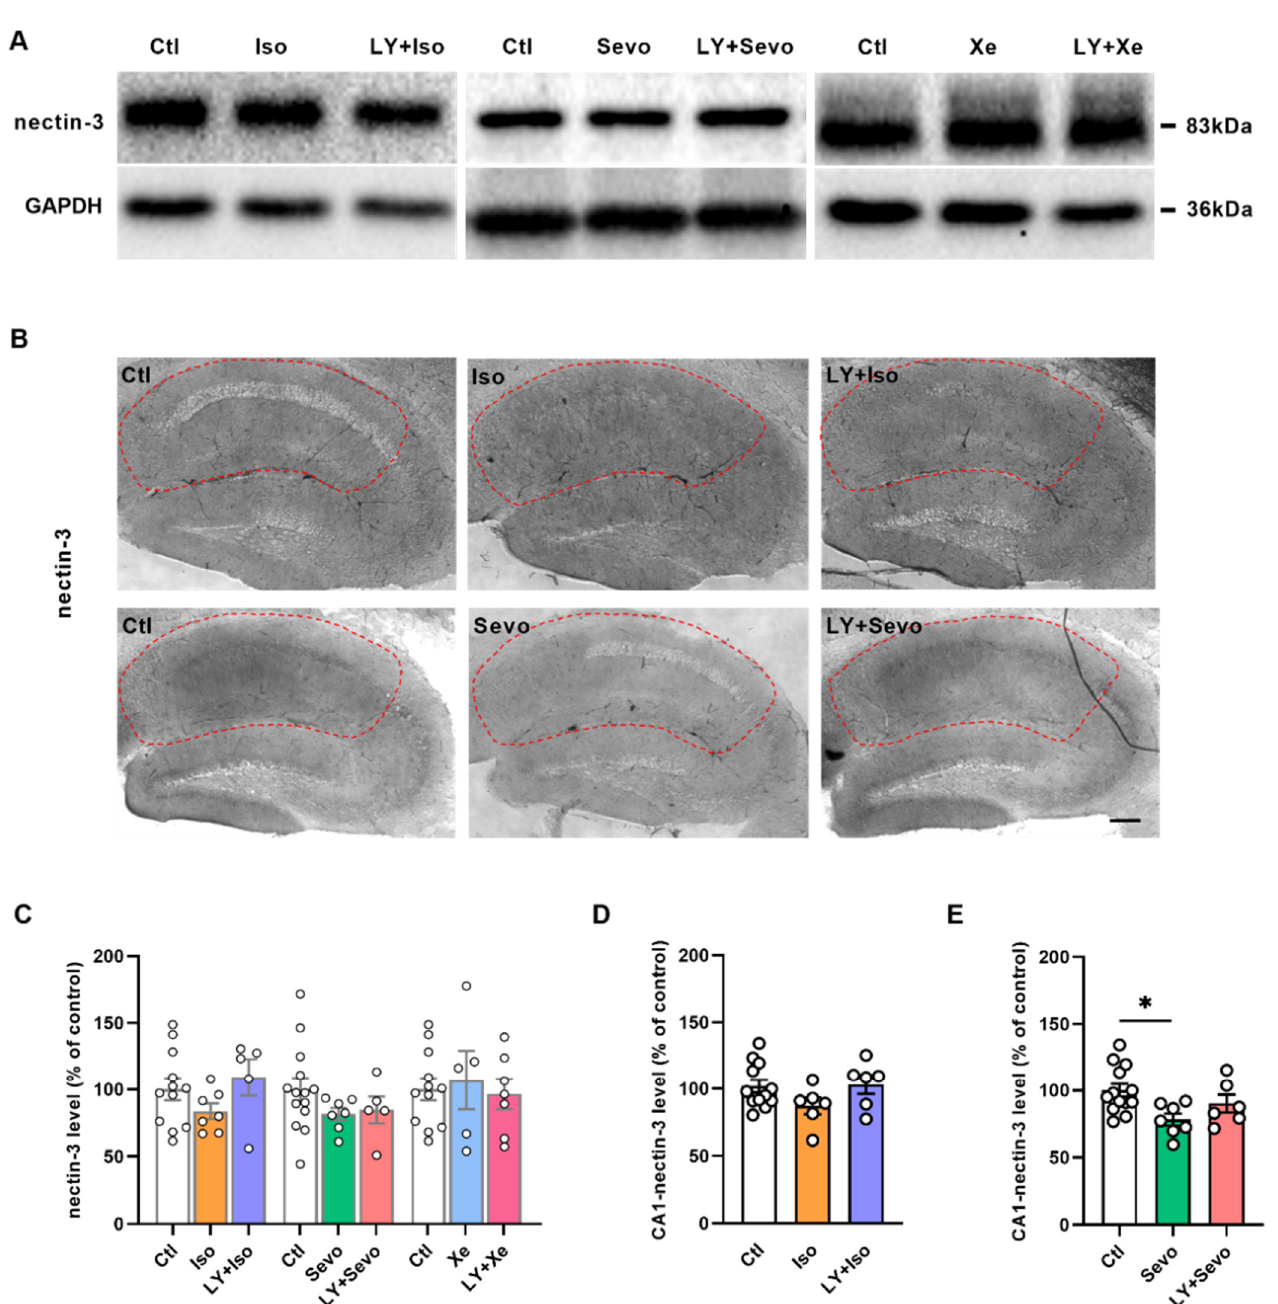
Figure 4. Reduced nectin-3 levels in CA1 by sevo were reversed by BACE inhibition. ( A ) Representative nectin-3 bands by Western blot. ( B ) Representative nectin-3 images by immunohistochemistry in the CA1 region (in the red circle). ( C ) Hippocampal nectin-3 levels measured by western blot were comparable between groups. ( D ) Regulation of nectin-3 levels by iso and LY + iso in CA1 region. ( E ) Sevo downregulated nectin-3 expressions in the CA1 region (ctl vs. sevo: p = 0.0205, Tukey’s test of one-way ANOVA ), which was restored by LY + sevo. Scale bar = 200 µm. Data are shown as mean ± SEM. Dots represent the number of animals. Detailed statistics are provided in Table S1. * p < 0.05. Ctl: control, GAPDH: glyceraldehyde 3-phosphate dehydrogenase, iso: isoflu-